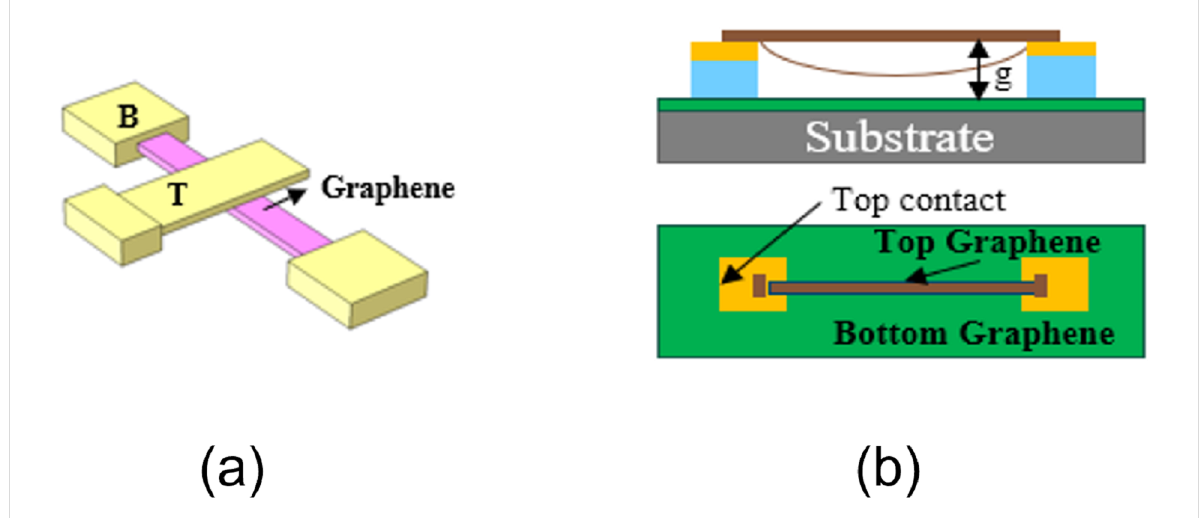
Figure 3: Structures of GR NEM switches. (a) GR-Au model and (b) GR-GR model. Figure 3a,b were redrawn from [7,29], respectively.